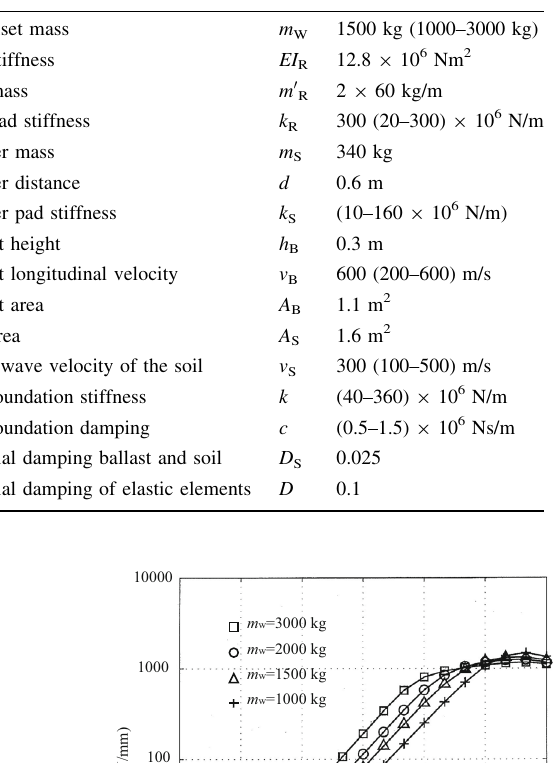
Table 1 Parameters of the emission part (per one sleeper)